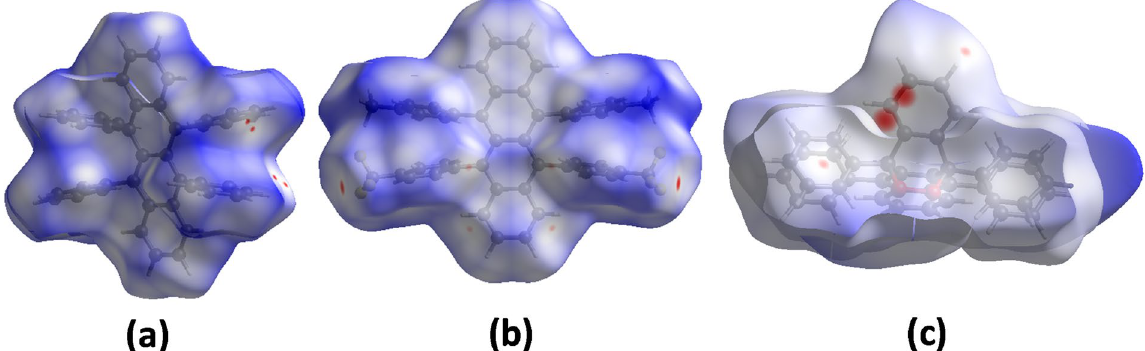
Figure 5. Hirshfeld surfaces mapped with normalized contact distance (d norm ) for rubrene ( a ), fm-rubrene ( b ), and oxidized rubrene ( c ).